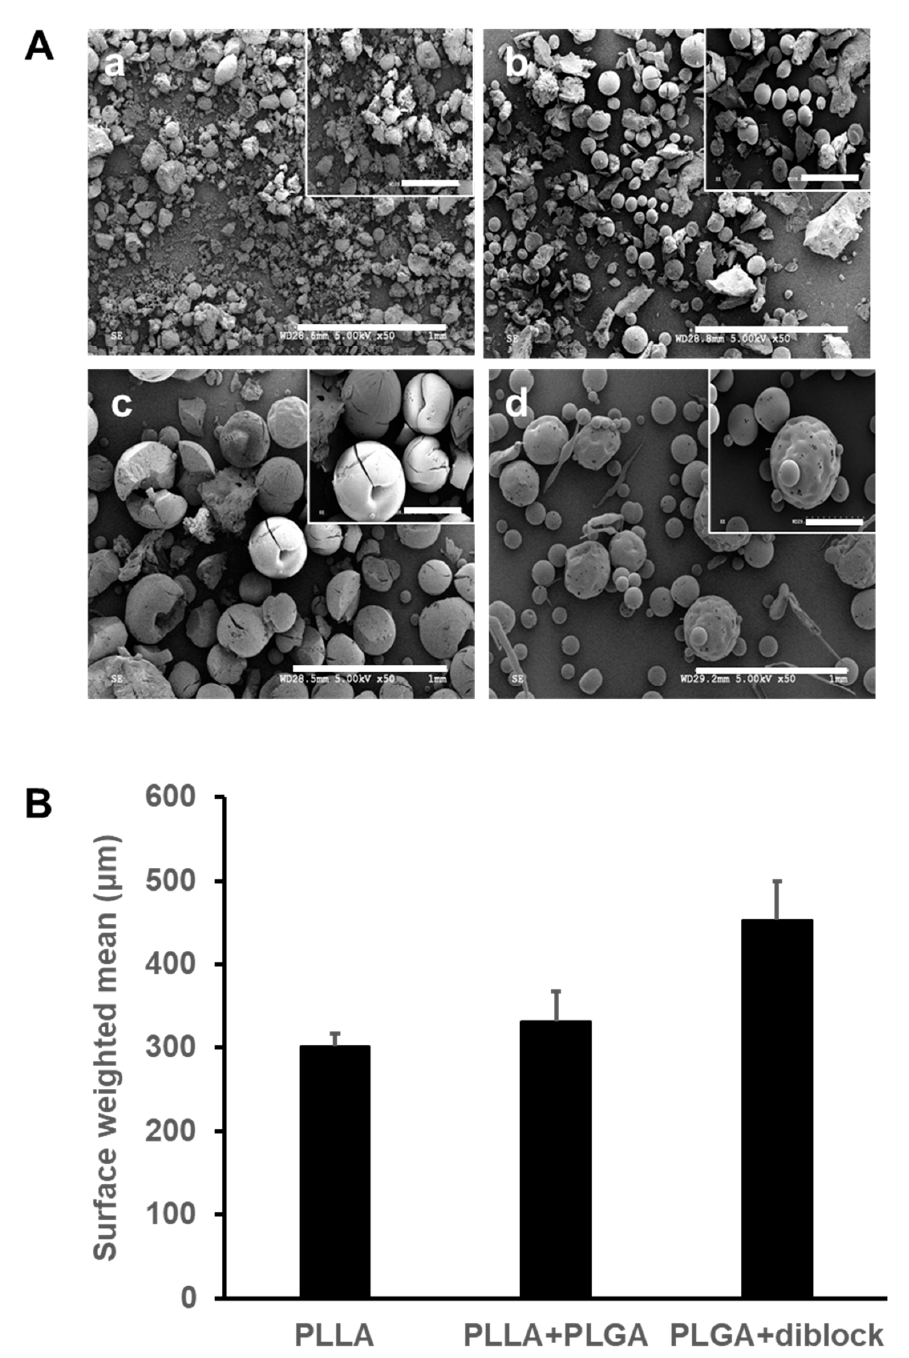
Figure 1. Scanning electron microscopy images and size of four different polymer formulations loaded with MTX. ( A ) PLLA 75% + MePEG diblock 20% formed particles ( a ), PLLA 95% formed small spherical microspheres mixed with particles ( b ), PLLA 75% + PLGA 20% ( c ), and PLGA 75% + MePEG-diblock 20% ( d ) formed mostly spherical microspheres. Multiple cracked and broken microspheres were seen with PLLA + PLGA formulation ( c ). Scale bar = 1 mm in main image and 300 µ m in insert. ( B ) surface weighted mean is reported as the mean diameters. The values are shown as the mean of four batches of microspheres ± one standard deviation.